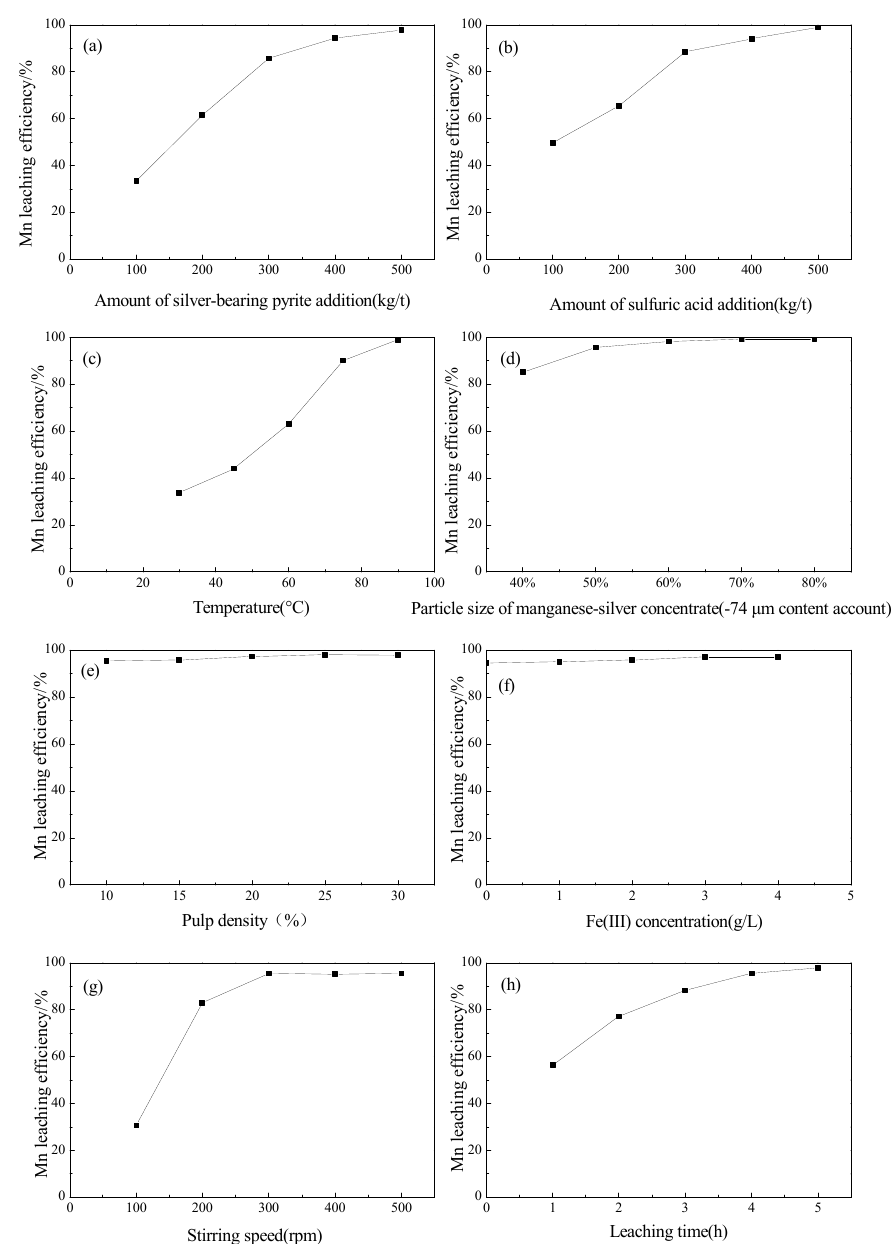
Figure 2. Changes in Mn leaching efficiency with amount of silver-bearing pyrite addition ( a ), amount of sulfuric acid addition ( b ), temperature ( c ), particle size of manganese–silver concentrate ( d ), pulp density ( e ), Fe(III) concentration ( f ), stirring speed ( h ) and leaching time ( g ). As shown in Figure 2, the best amount of silver-bearing pyrite addition is 500 kg/t with a Mn leaching efficiency of 97.84%, the best amount of sulfuric acid addition is 500 kg/t with a Mn leaching efficiency of 99.11%, the best reaction temperature is 90 °C with